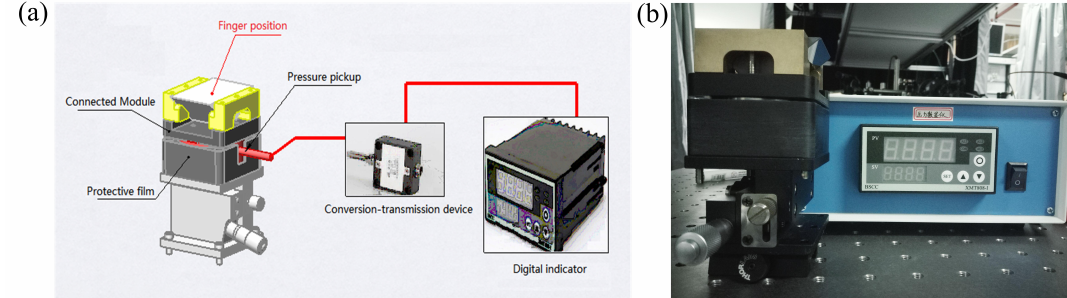
Figure 2. ( a ) The schematic diagram of the digital pressure sensor array device. ( b ) The setup of the digital pressure sensor array